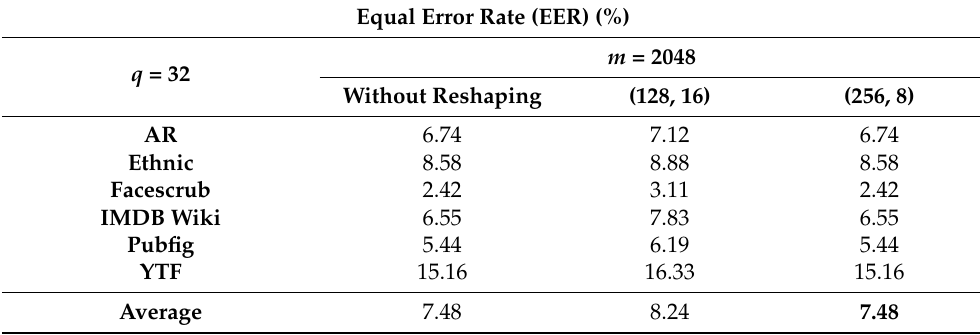
= 4096 and = 32. 𝑚𝑚 𝑞𝑞